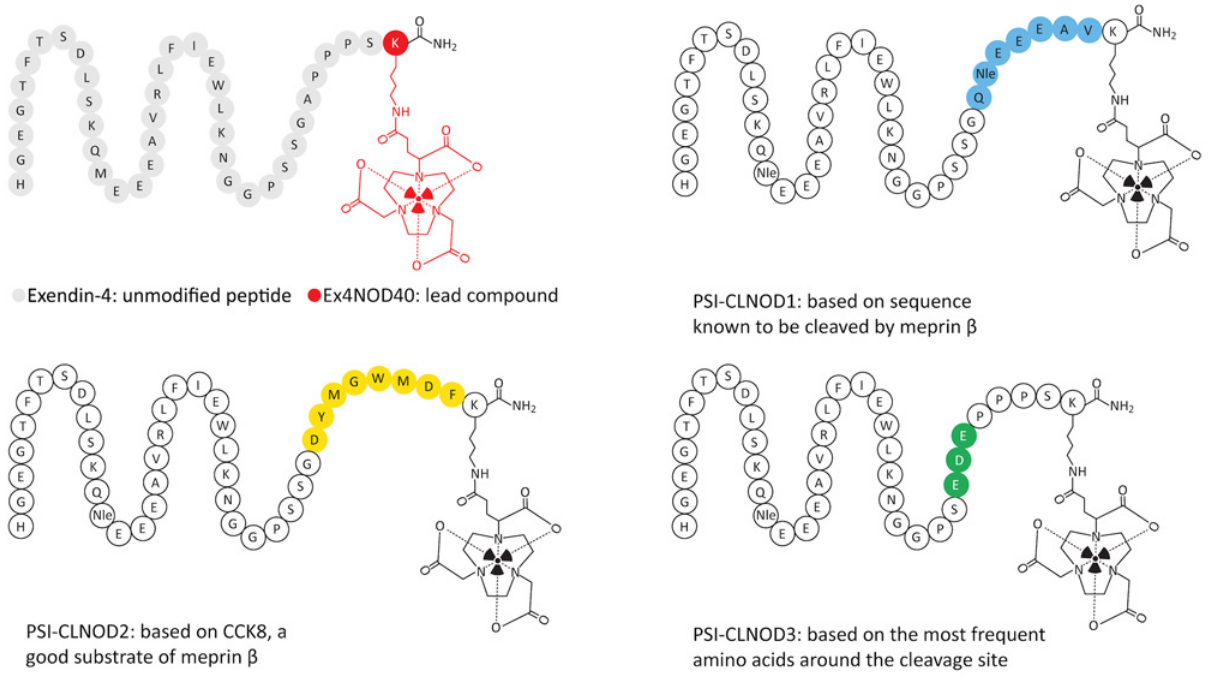
Fig 2. Graphical representation of exendin-4 and its derivatives. The linkers are highlighted in different colours.